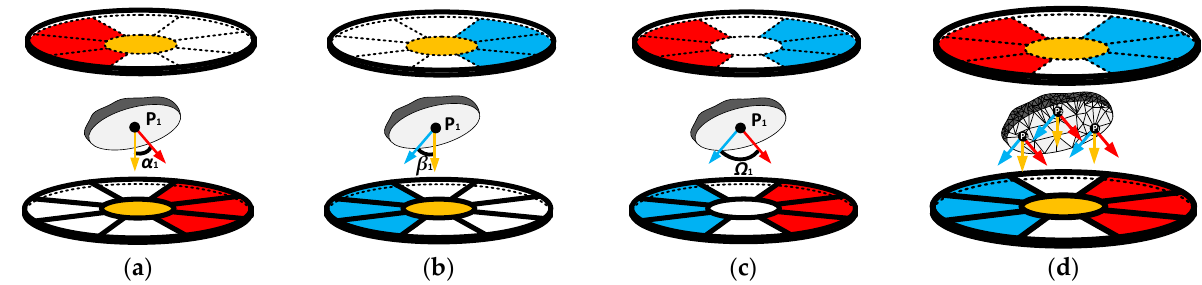
Figure 7. Example of evaluation of independent electric field vectors: ( a ) angle between the electric field vectors produced by red CS and configuration yellow CS, ( b ) angle between the electric field vectors produced by blue CS and configuration yellow CS, ( c ) angle between the electric field vectors produced by blue CS and configuration red CS and ( d ) evaluation of independent electric field vectors in each point of the mesh.